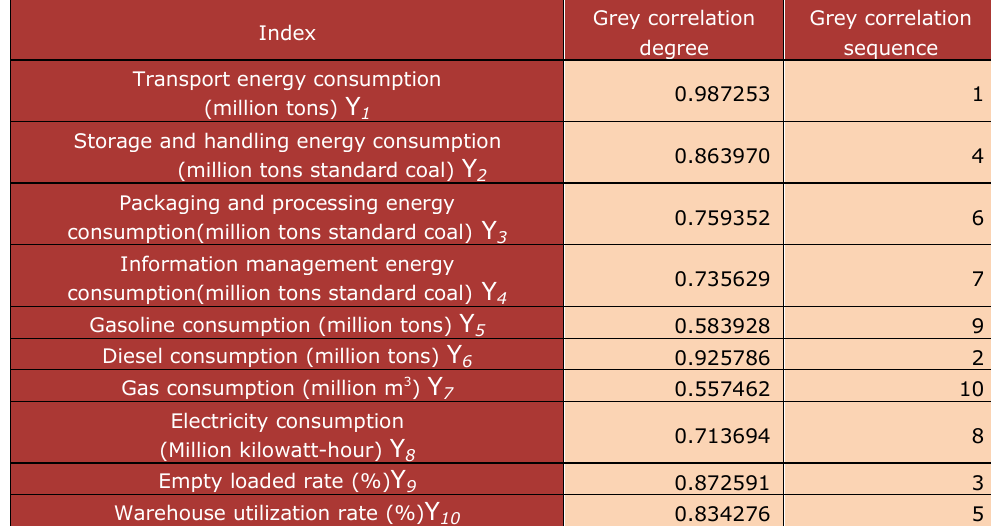
Tab.3 the connection degree of logistics energy consumption and its related